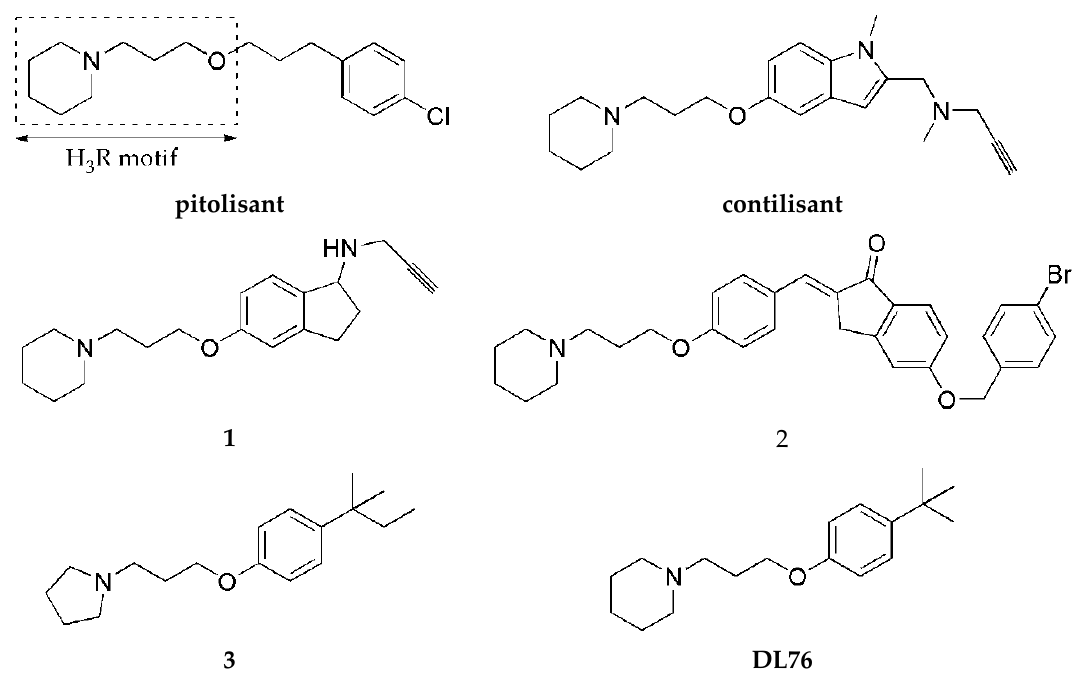
Figure 2. Structures of pitolisant and histamine H 3 receptor ligands with MAO B inhibitory activity.